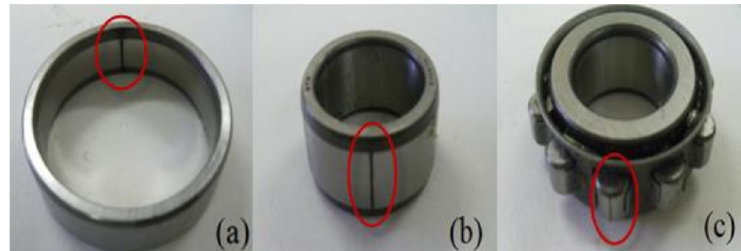
Figure 11. Bearing fault: ( a ) outer-race fault, ( b ) inner-race fault, and ( c ) roller element fault.